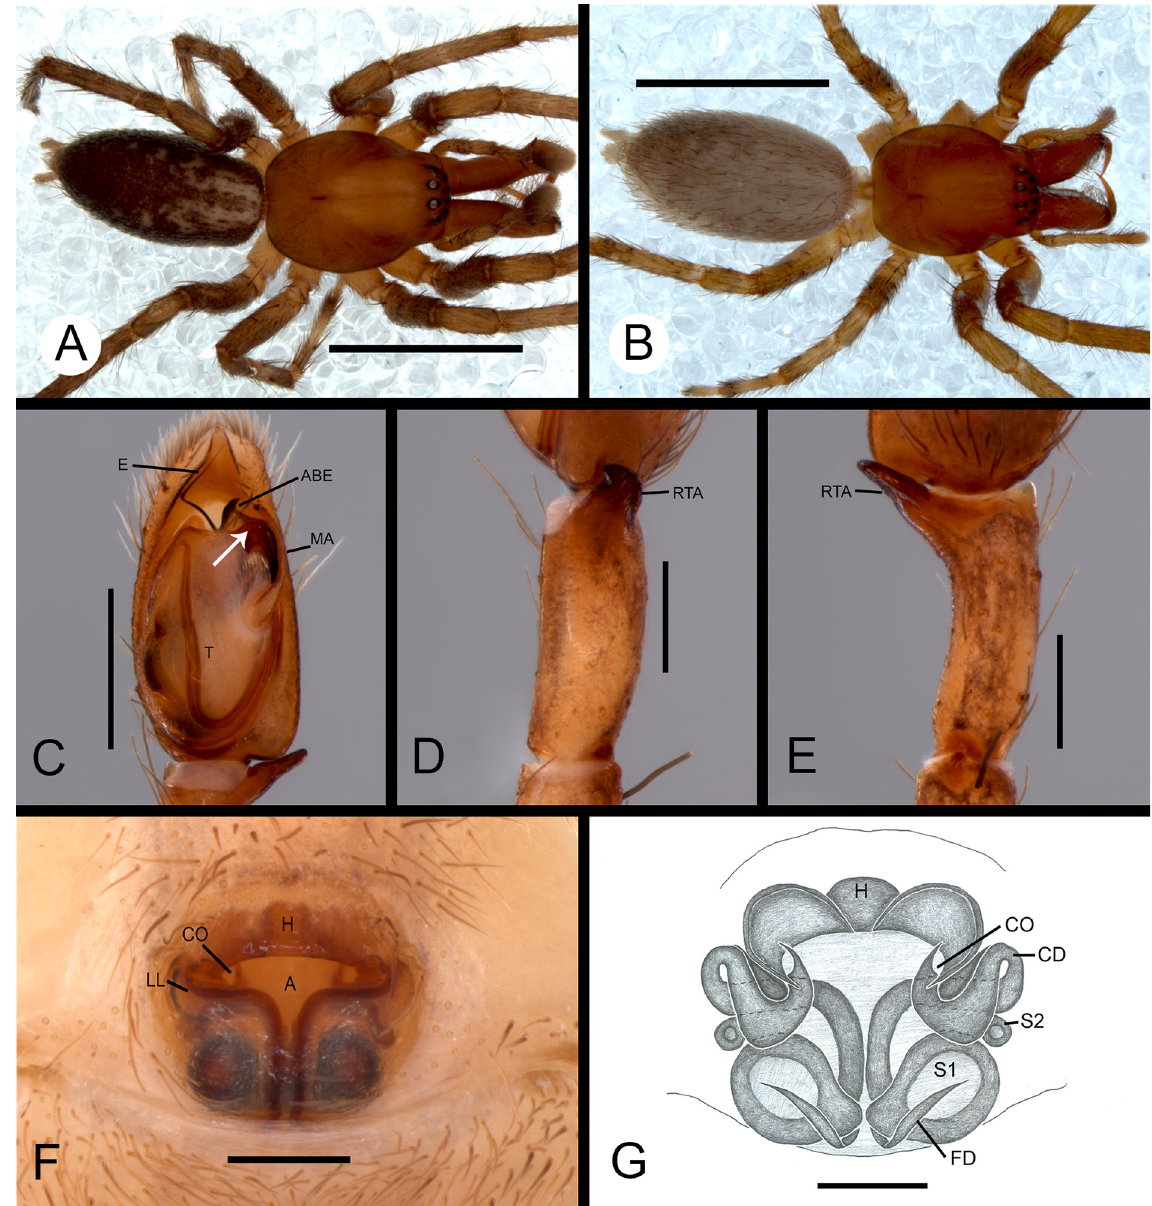
Fig. 21. Tafana ruizi sp. nov. (A, C–E = holotype, ♂, IBSP 258183; B, E–F = paratype, ♀, IBSP 258183). A . Habitus, dorsal view. B . Habitus, dorsal view. C . Left palp, ventral view (arrow indicating the base of the embolus). D . Left palp, retrolateral view. E . Left palp, dorsal view. F . Epigynum, ventral view. G . Vulva, dorsal view. Abbreviations: A = atrium; ABE = apophysis of base of the embolus; CD = copulatory ducts; CO = copulatory opening; E = embolus; FD = fertilization ducts; H = hood; LL = lateral lobes; MA = median apophysis; RTA = retrolateral tibial apophysis; S1 = primary spermathecae; S2 = secondary spermathecae; T = tegulum. Scale bars: A–B = 3.5 mm; C = 0.5 mm; D–G = 0.25